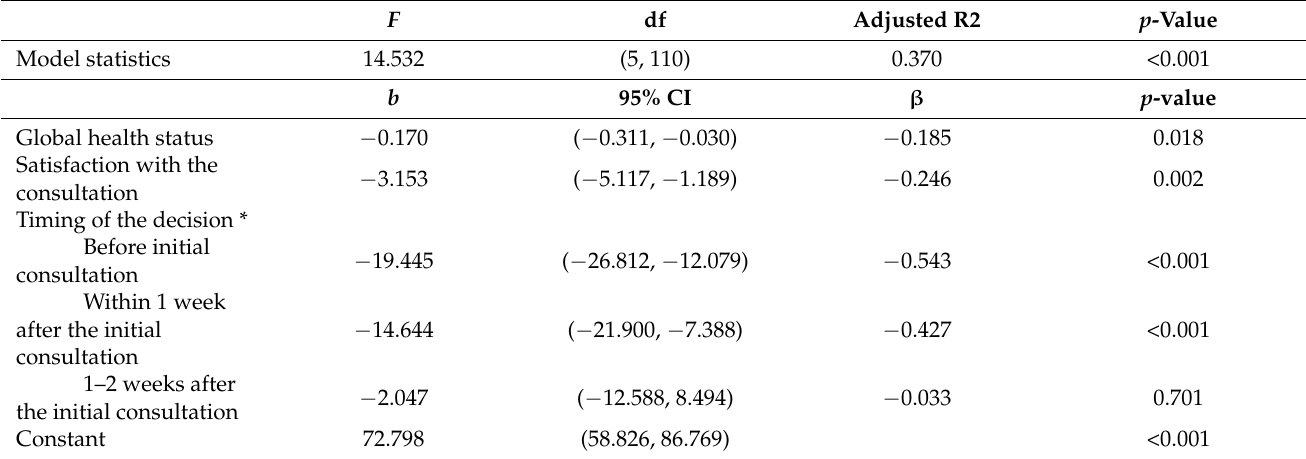
Table 5. Linear model of predictors of DCS